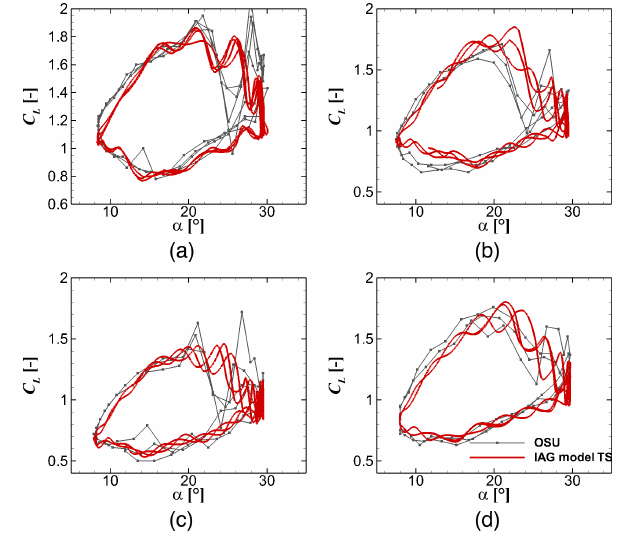
Figure 23. Lift reconstruction by the IAG model in compari- son with the measurement data (Ramsay et al., 1996; Hoffman et al., 1996; Ramsay et al., 1995; Janiszewska et al., 1996) for (cid:49)t = T/ 1440 using the actual angle of attack in the experimen- tal campaign for different airfoils. From (a) to (d) : S801 (13.5%), NACA4415 (15%), S809 (21%) and S814 (24%). k = 0 . 073, α = 20 ◦ and (cid:49)α = 10 ◦ .